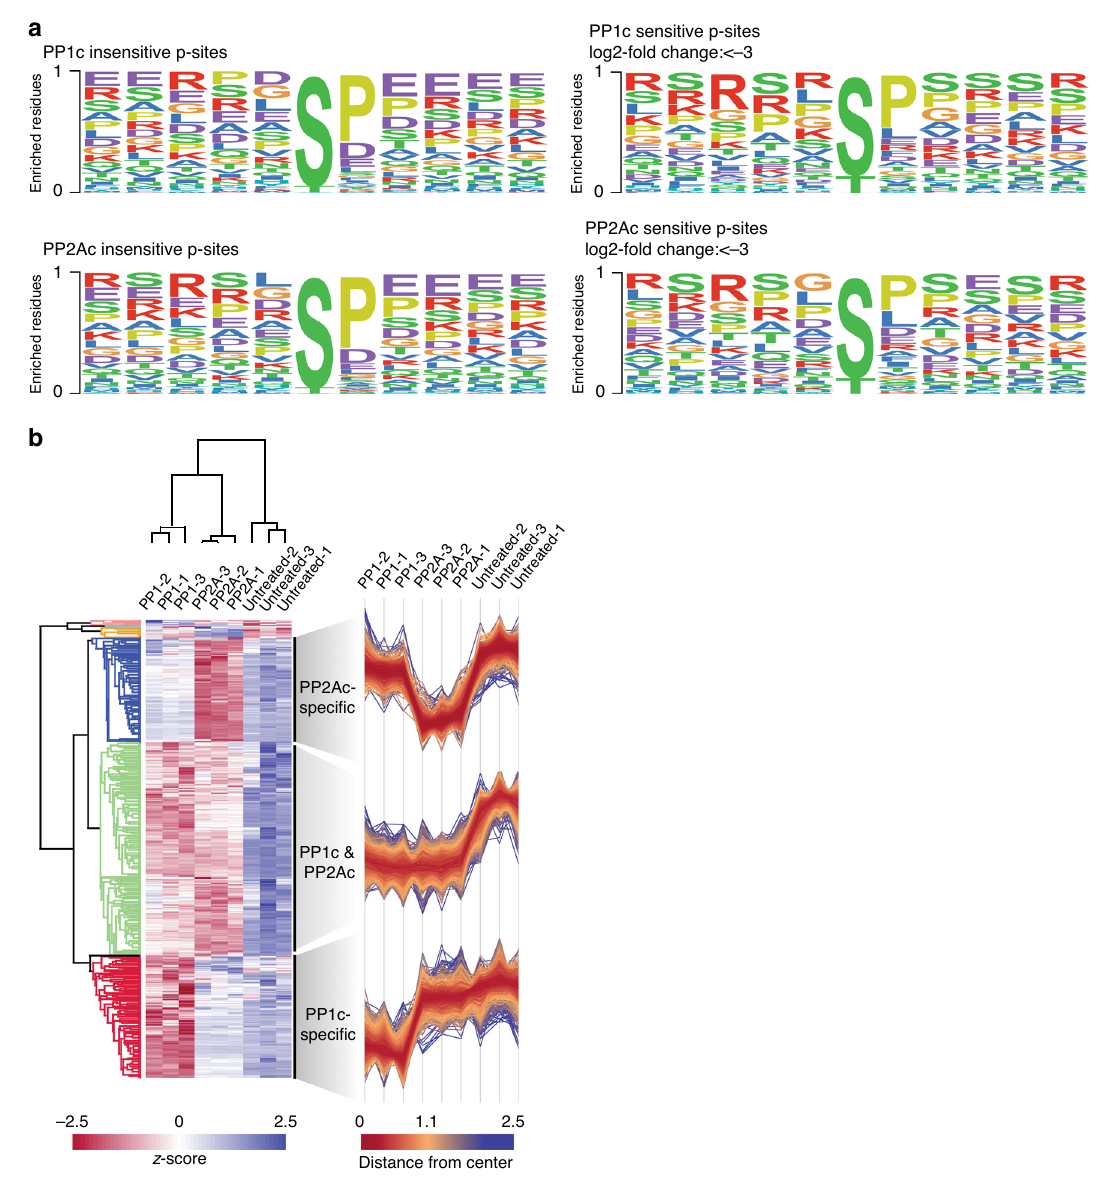
Fig. 5 Analysis of PP1c/PP2Ac-affected p-sites. The data are from the phosphoproteomic experiments (Supplementary Data 2; Supplementary Fig. 4b, c). a Motif analysis of PP1c/PP2Ac (in)sensitive class I sites. Color of single letter code represents biochemical properties with red = basic, purple = acidic. The enrichment of R in PP1c-sensitive p-sites over PP2Ac-sensitive sites was tested by a two-sided Fisher ’ s exact test and was found to be statistically different ( p -value 0.019). Source data are provided as a Source Data fi le. b Hierarchical clustering of p-sites after one-way ANOVA analysis using Perseus software. Color scale represents log2-fold change after z-transformation. The three largest clusters are depicted in detail on the right. Each line corresponds to one p-site. These data are also the basis for PP1c/PP2Ac-speci fi c sites presented in Table